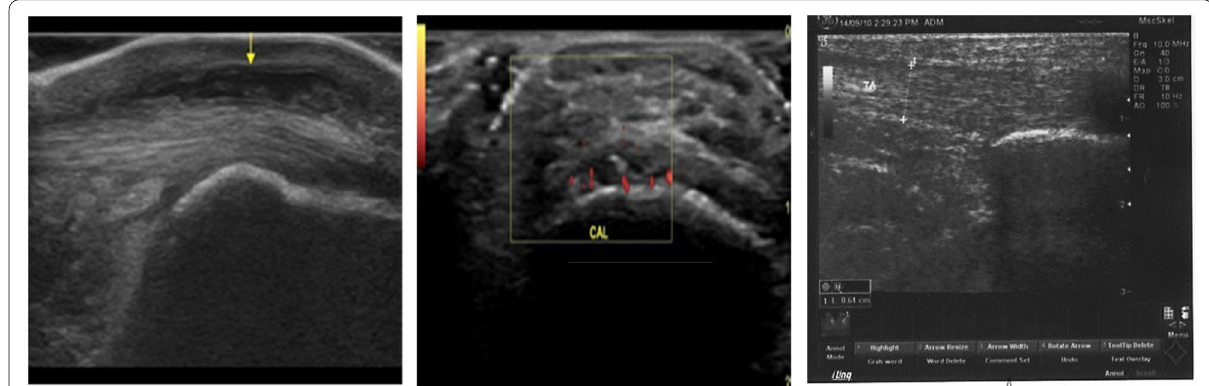
Fig. 1 A Longitudinal B‑mode superficial ultrasound of the dorsal ankle showing retro calcaneal bursitis seen as hypoechoic thick walled fluid filled bursa at the retro calcaneal space. B Longitudinal color Doppler superficial ultrasound of the planter aspect of the foot showing thickened planter fascia with increased vascularity denoting planter fasciitis, cal (calcaneus(. C Longitudinal B‑mode superficial ultrasound at the level of the dorsal ankle showing thickened tendo‑Achilles tendon (between calibers 6.4 mm)